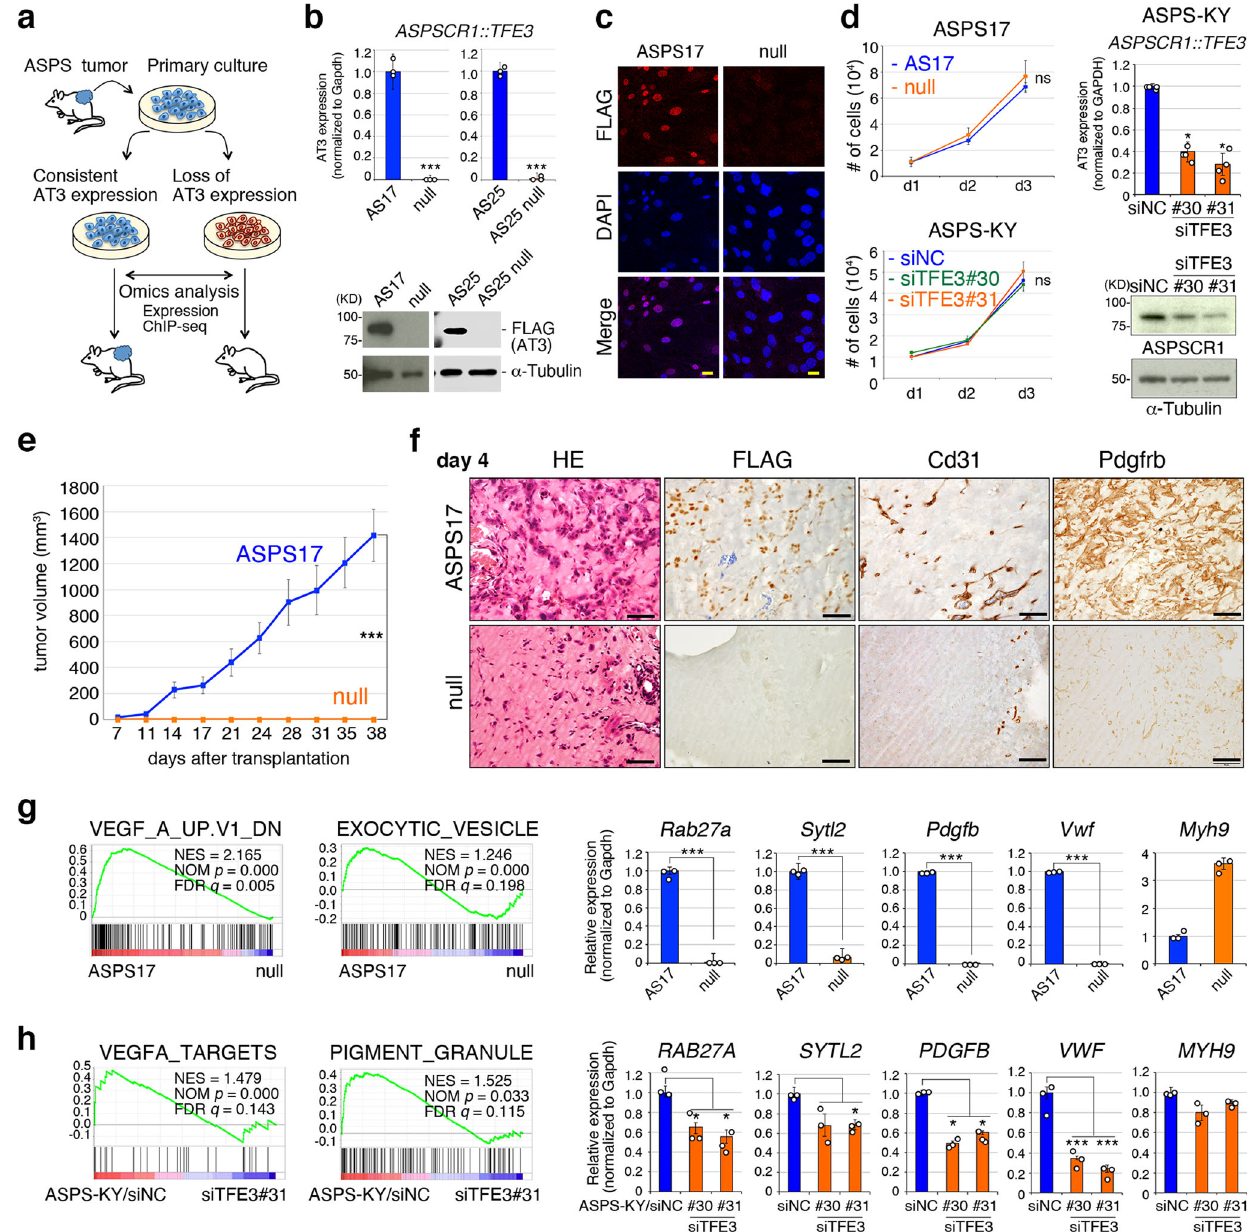
Fig. 1 | ASPSCR1::TFE3 expression is dispensable for cell maintenance in vitro but requiredfor in vivotumordevelopment in ASPS. a Schematic illustration of functional analysis in ASPS cells with or without ASPSCR1::TFE3 expression. b ASPSCR1::TFE3 expression in ASPS17 and ASPS25 was compared with their null counterparts at the transcriptional level (top) ( n =3 per group) and protein levels (bottom, two representative immunoblots from eight independent experiments). c Loss of the ASPSCR1::TFE3 protein in ASPS null cells exhibited by immuno- fl uorescence using the anti-FLAG antibody. Scale bar: 20 µ m. Experiments repre- sent fi ve biological replicates. d Cell proliferation of mouse ASPS17 and ASPS null cells(left,top),andhumanASPS-KYcellswithsiRNAtreatment(left,bottom)( n =4 per group). ns: no signi fi cance. The ef fi ciency of ASPSCR1::TFE3 knockdown is shown at transcriptional ( n =4 per group) and protein levels (right, representative immunoblots from fi ve independent experiments). e Suppression of tumor developmentbylossof ASPSCR1::TFE3 expression.AveragetumorvolumeswithSD areshownintherecipienttransplantedwithASPS17andASPSnullcells( n =6mice/ 12 independent tumors per group). The tumor volume was measured using 2 tumorspermouse. f HistologyoftransplantedareawithASPS17andASPSnullcells